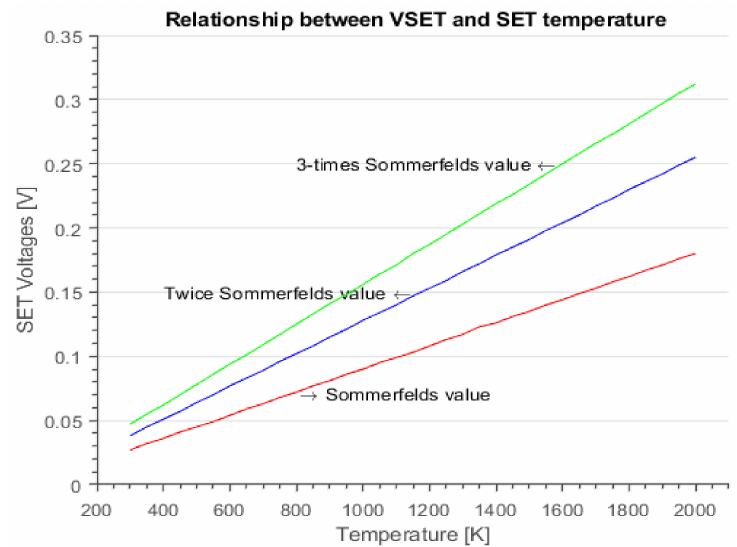
Figure 11. Relation between the SET voltage and temperature.